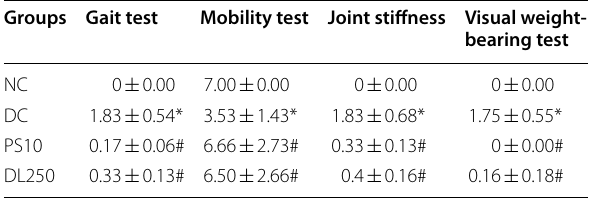
Table 3 Effect of C. procera on functional parameters of CFA- induced arthritic